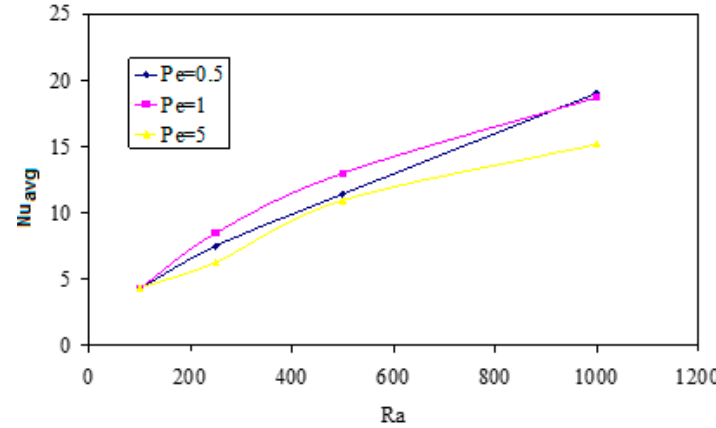
Figure 9 Variation of average Nusselt number with Rayleigh number ( c = 0.66)